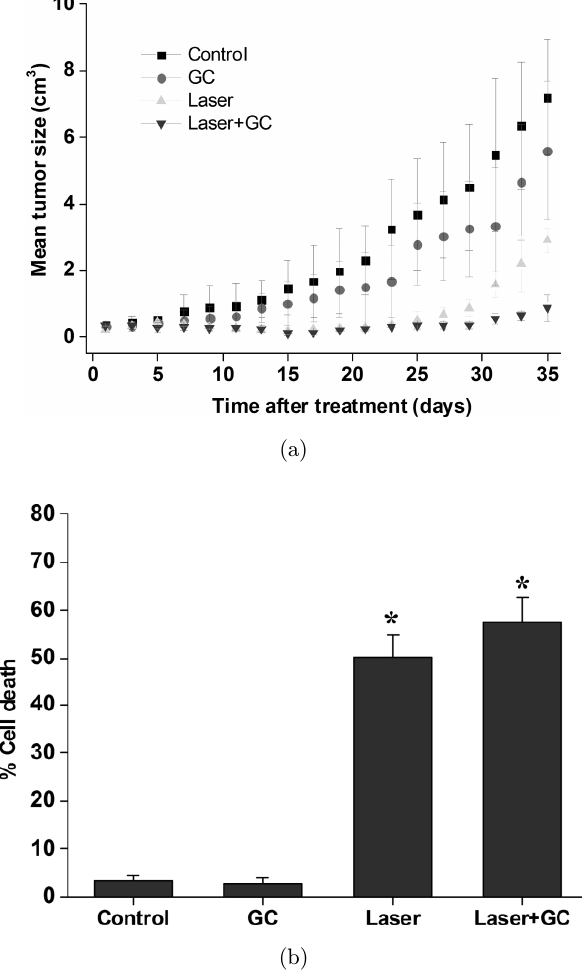
Fig. 1. In vivo cytotoxicity assays. EMT6 cells were subcu- taneously injected in the °anks of Balb/c female mice, and treatment took place when tumors reached a size of approxi- mately 300 mm 3 . Tumors were treated with intratumoral injections of di®erent components, followed by laser irradiation (0.75 W/cm 2 for 10 min): (i) Control, (ii) GC (25 mg/kg), (iii) Laser only, (iv) laser þ GC (25 mg/kg). (a) Volumetric changes in tumor sizes of di®erent treatment groups. (b) Analysis of cell death. Tumors were excised 3 h after di®erent treatments, dissociated into single cell suspensions and labeled with Annexin V-FITC, analyzed by FACS. Bars, means (cid:2) SD ( n ¼ 4), * p < 0 : 05.